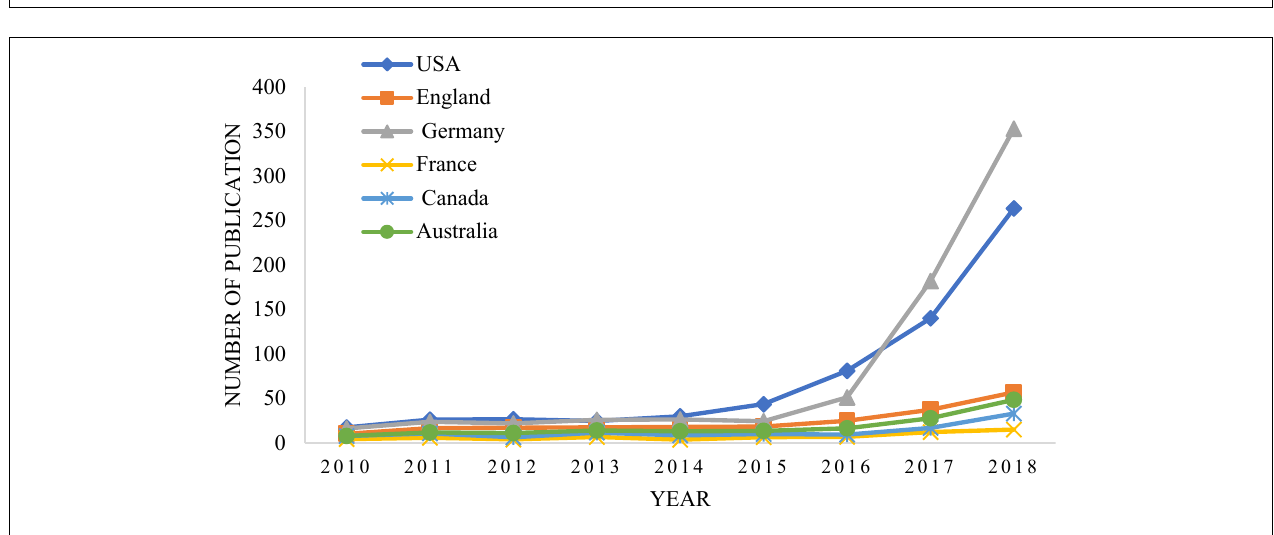
FIGURE 3 | Changes in the application trend of artificial intelligence based on deep learning in the legal field in some Asian countries from 2010 to 2018.